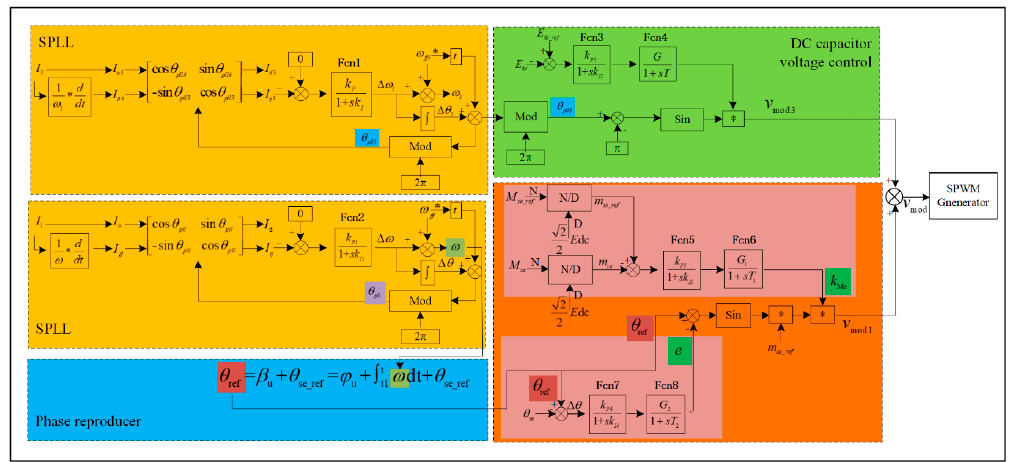
Figure 6. The scheme of the DPFC series unit controller.